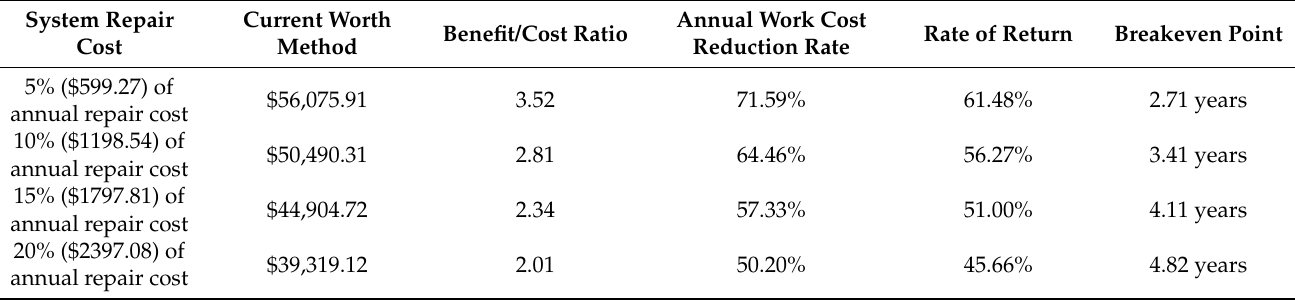
Table A4. Sensitivity analysis results according to the system repair